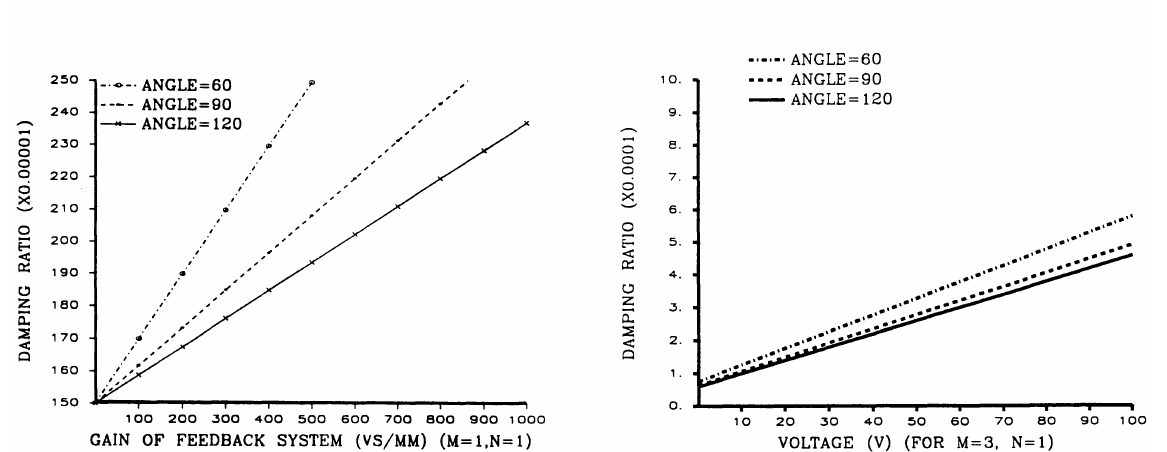
FIGURE 11 Damping control of the piezoelectric shell, (3, 1)